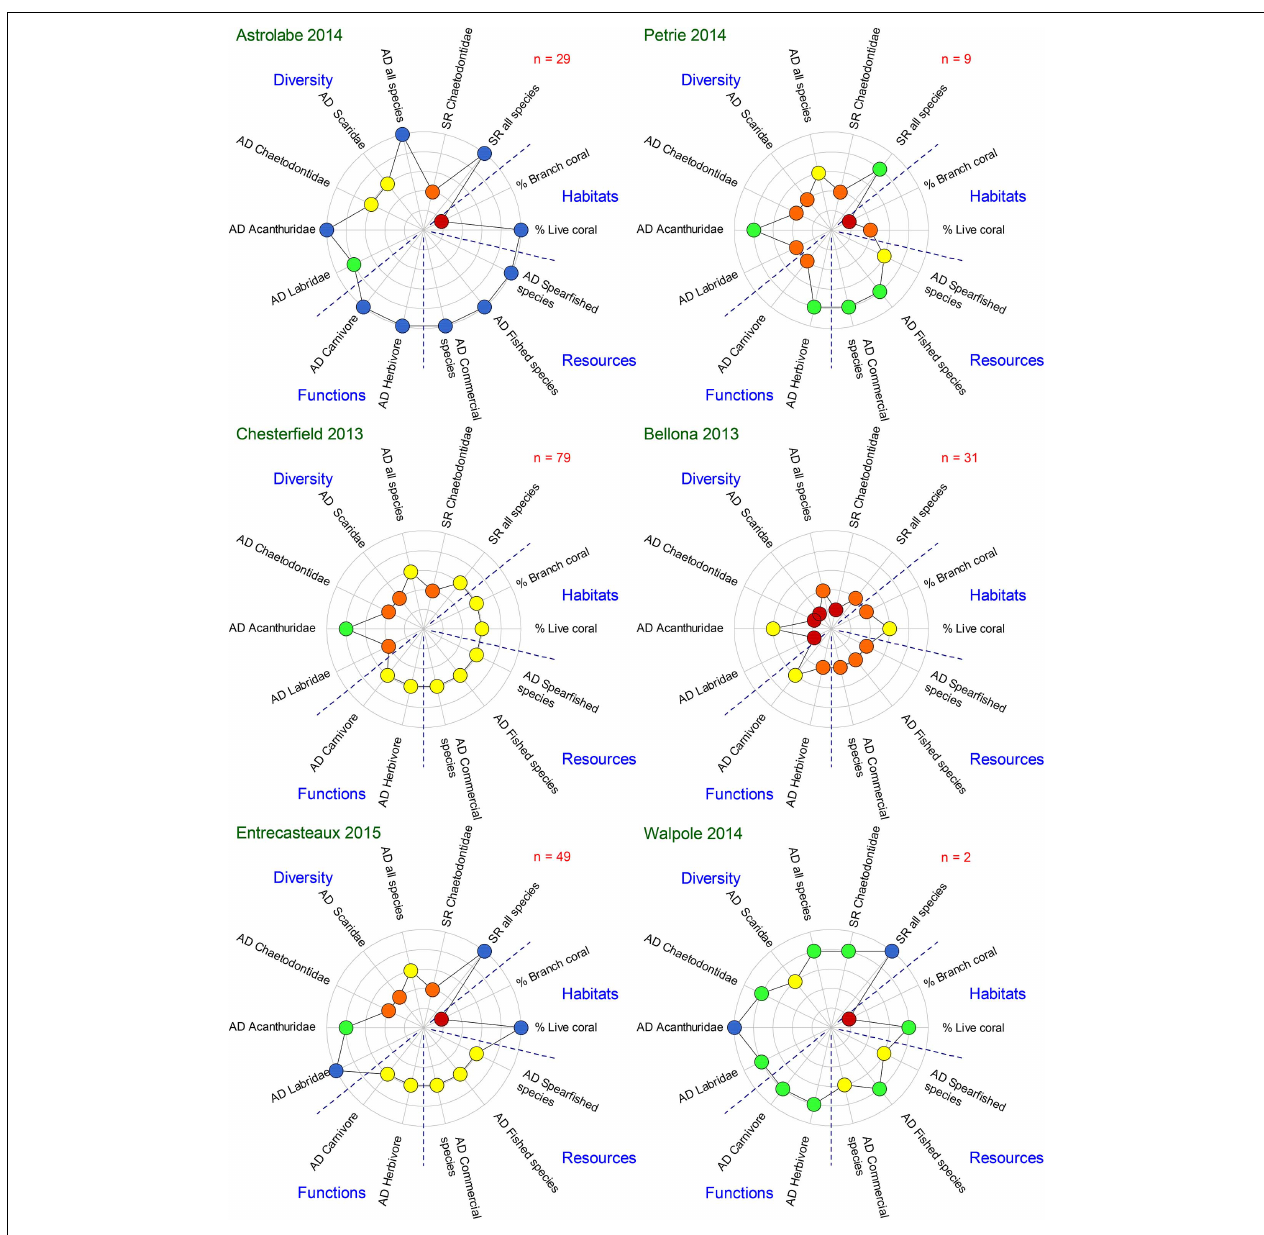
FIGURE 8 | Cross-site comparison of ecological status of the main reef areas in the Coral Sea Marine Park, New Caledonia. The locations of the reefs are showed on Figure 4 . AD and SR stands for abundance density and species richness,